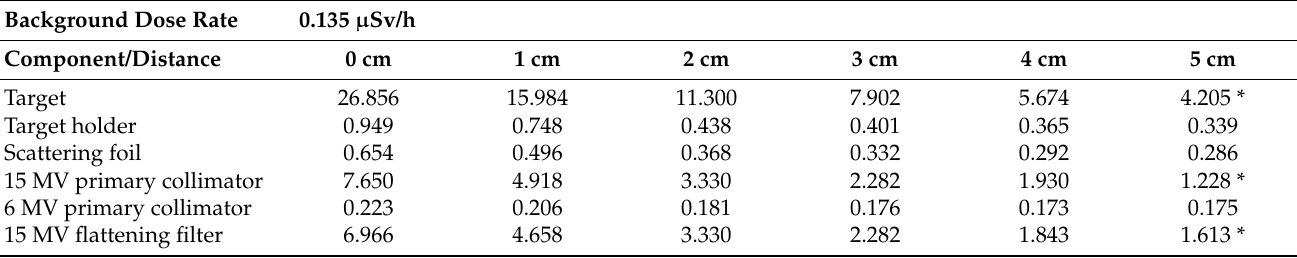
Table 3. On the day of disposal: Dose rate according to the distance of components ( µ